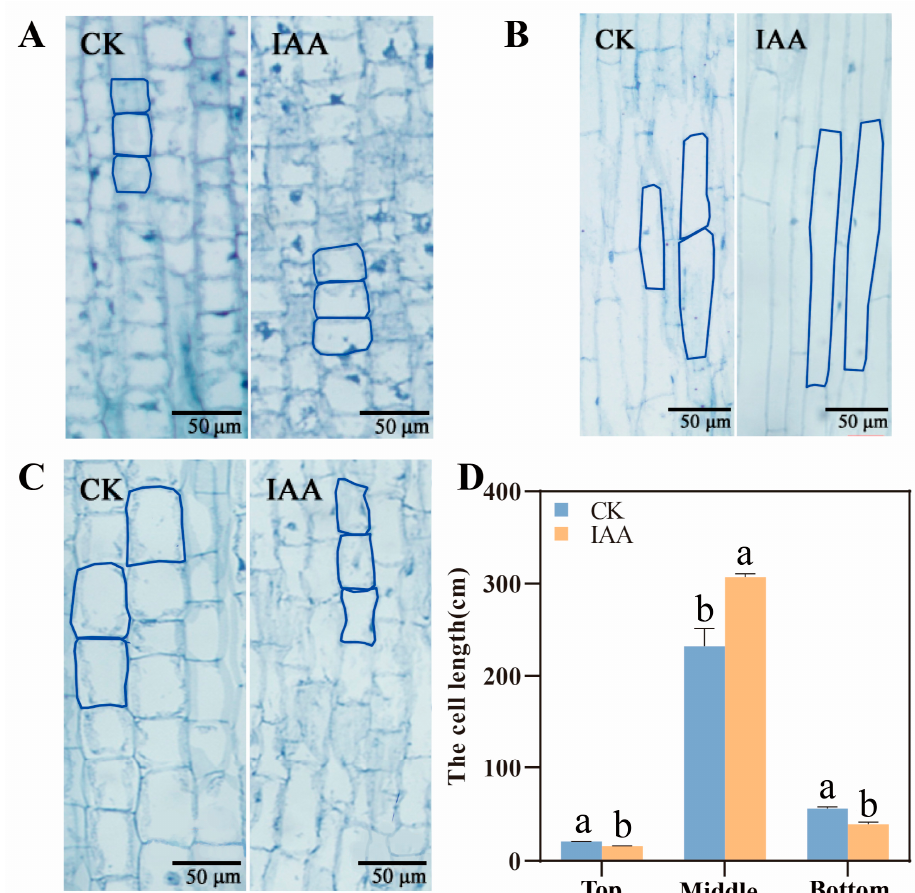
Figure 4. Cell length of different parts of mesocotyl in line Z210. ( A ) The up part of mesocotyl cell in CK and IAA treatment under the vision of stereomicroscope in Z210; ( B ) The middle part of mesocotyl cell in CK and IAA treatment under the vision of stereomicroscope in Z210; ( C ) The down part of mesocotyl cell in CK and IAA treatment under the vision of stereomicroscope in Z210; ( D ) The cell length statistics of different part of mesocotyl in Z210. Lowercase letters indicate statistical differences ( p ≤ 0.05) among treatments.